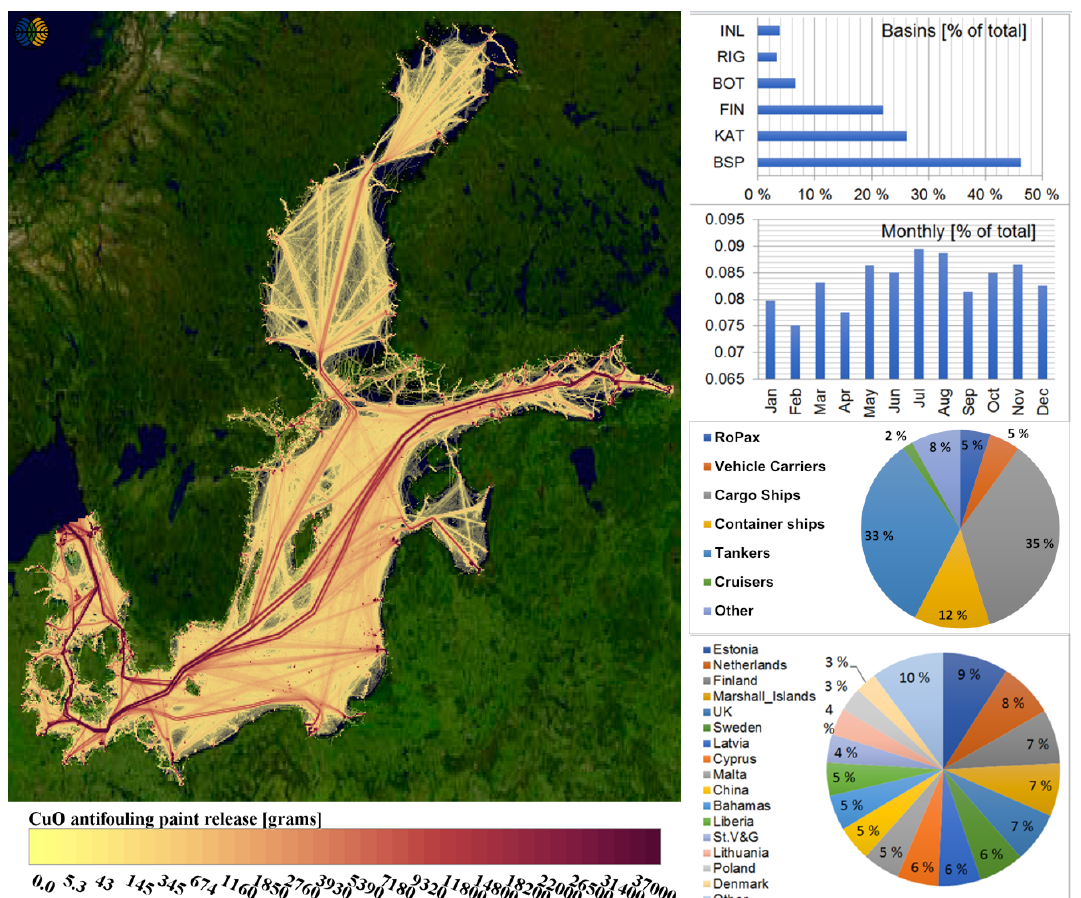
Figure 9. Geographical distribution of the emissions of Cu(I)O from ship hull antifouling paints. The values reported by the colour scale indicate CuO releases in units of grams per map grid cell of 5km 2 . Top right bar chart indicates the share of Cu(I)O releases by sea area (INL: inland areas; RIG: Gulf of Riga; BOT: Bothnian Sea and Bothnian Bay; FIN: Gulf of Finland; KAT: Kattegat; BSP: Baltic proper). The lower bar chart describes the monthly variation in CuO releases. The upper pie chart illustrates the estimated share of various ship types and the lower pie chart the flag state contributions to CuO releases. Map: background Landsat-8 image courtesy of the US Geological